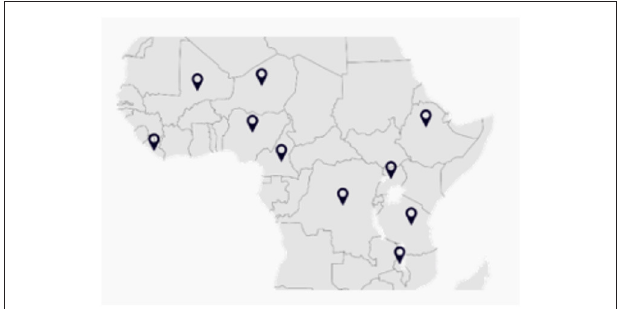
FIGURE 1 | Selected countries for the study.